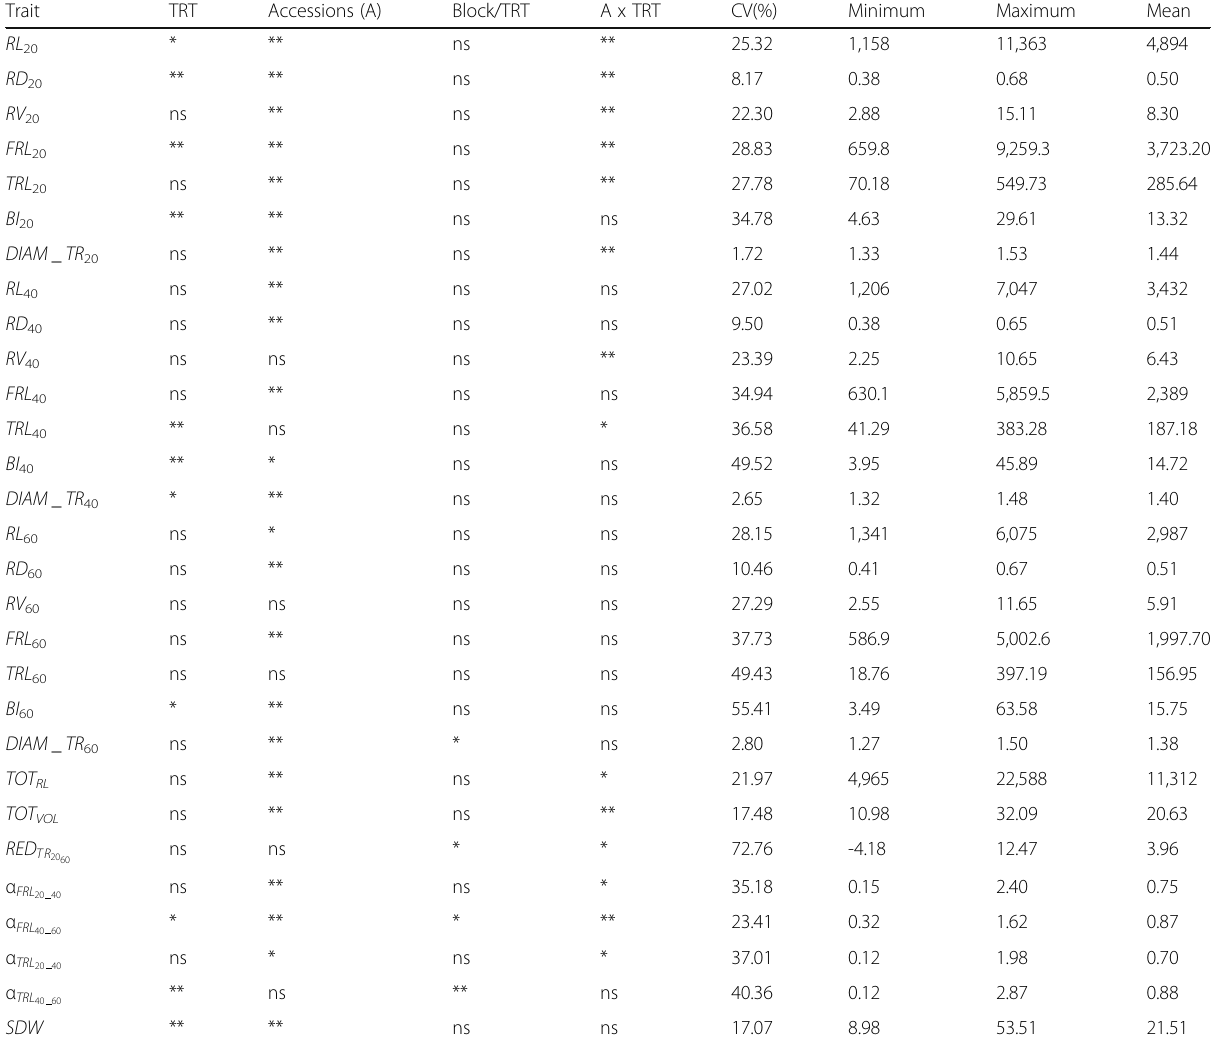
Table 2 Descriptive statistics of all measured traits in the japonica rice panel and significance of Anova Trait